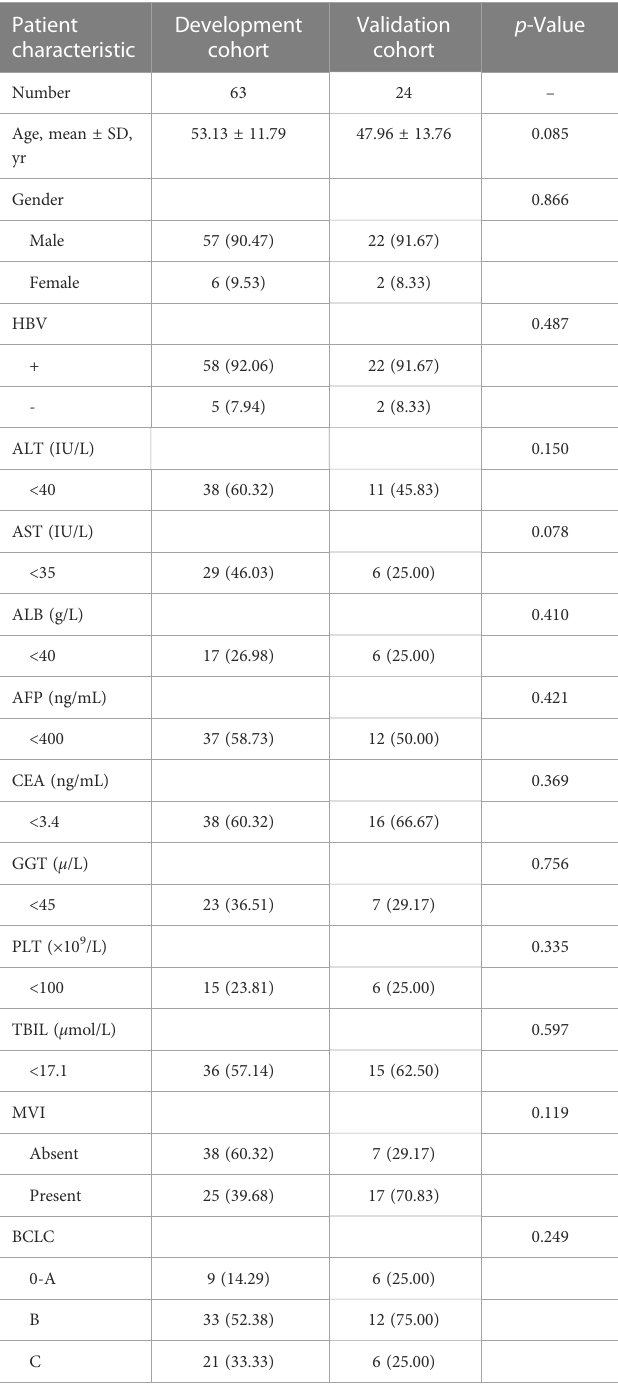
TABLE 1 The clinical characteristics of patients with HCC in the training and validation cohorts. Patient